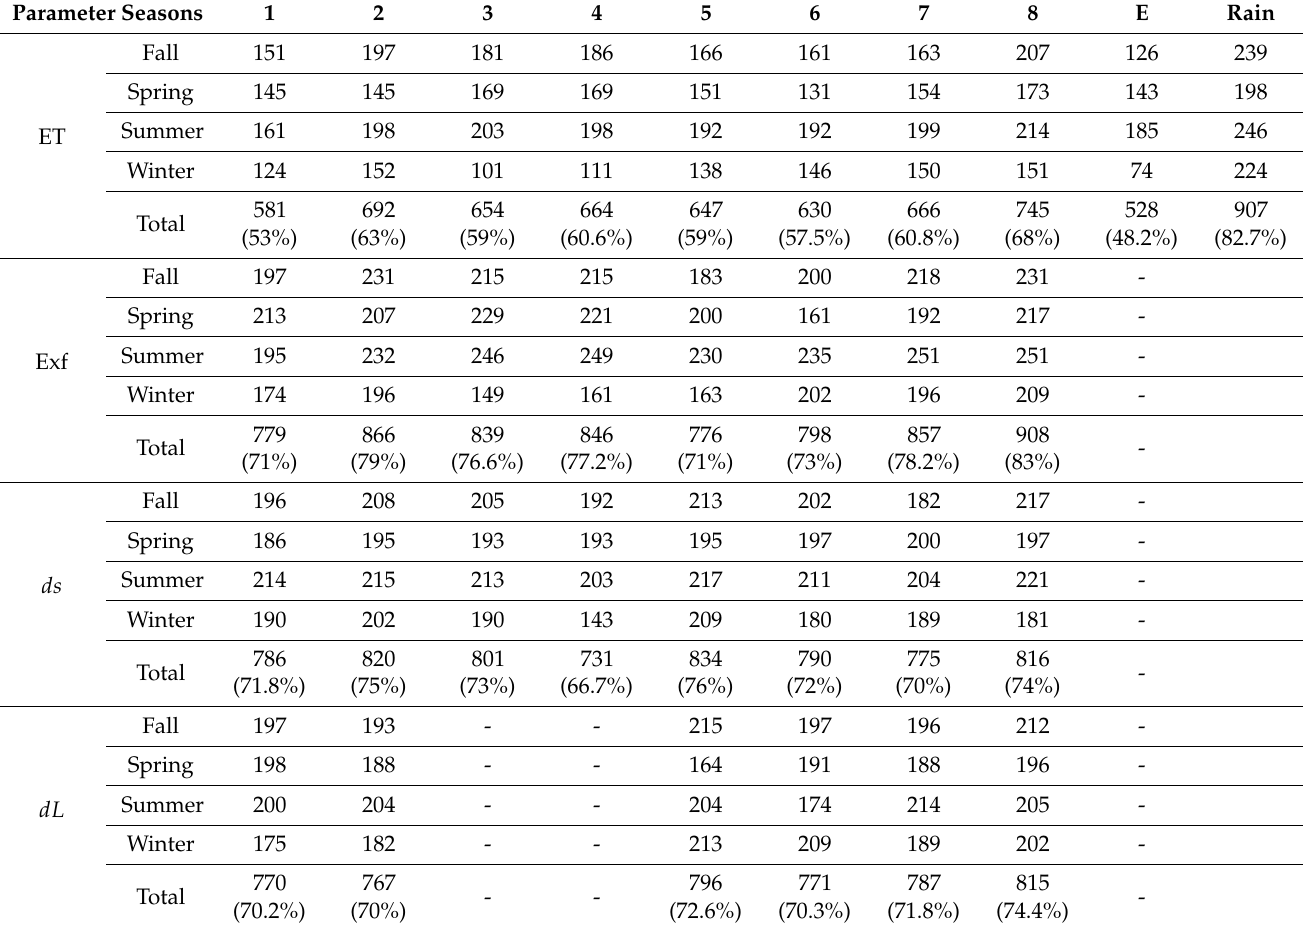
Table A1. Validated data after processing for the three years (2016–2019). The numbers and the symbol “E” refer respectively to lysimeters and evaporimeter. For season, it was considered